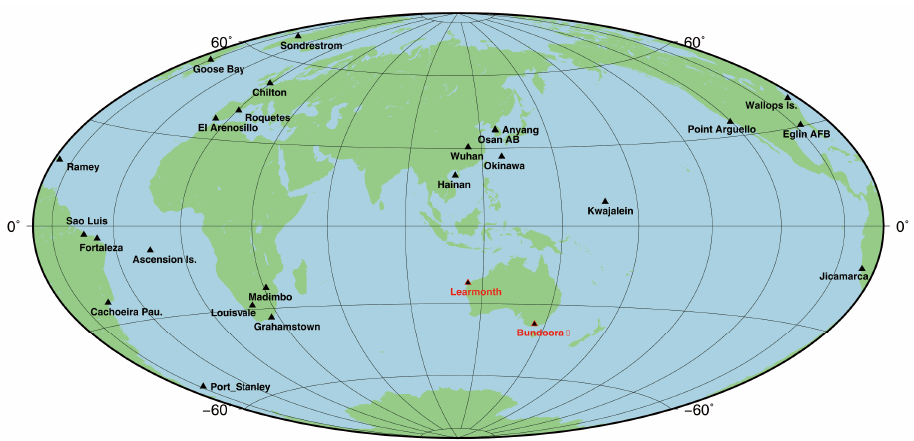
Figure 9. Global ionosonde station selected by the AMTB model